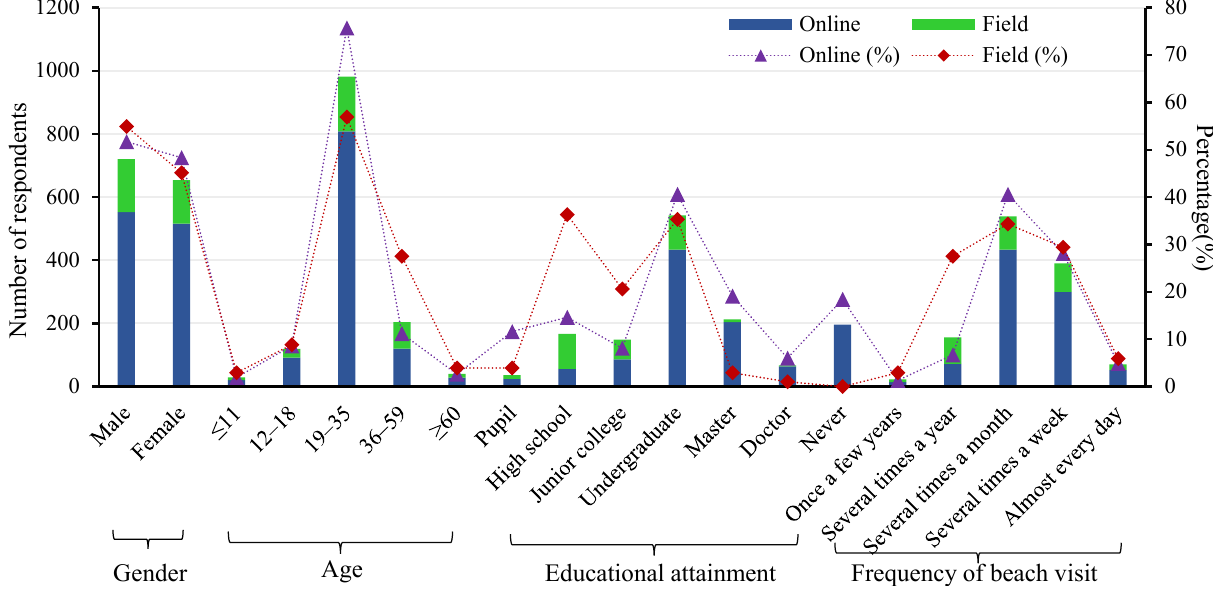
Figure 6. Demographic characteristics of online and field respondents, including gender, age, educational attainment and frequency of beach visit. The bar chart indicates the number of respondents, and the line chart indicates the percentage of each indicator.